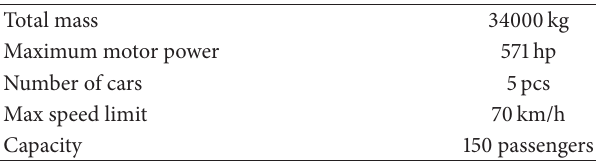
Table 1: Train characteristics. Table 2: Estimated motion phases for the parts of